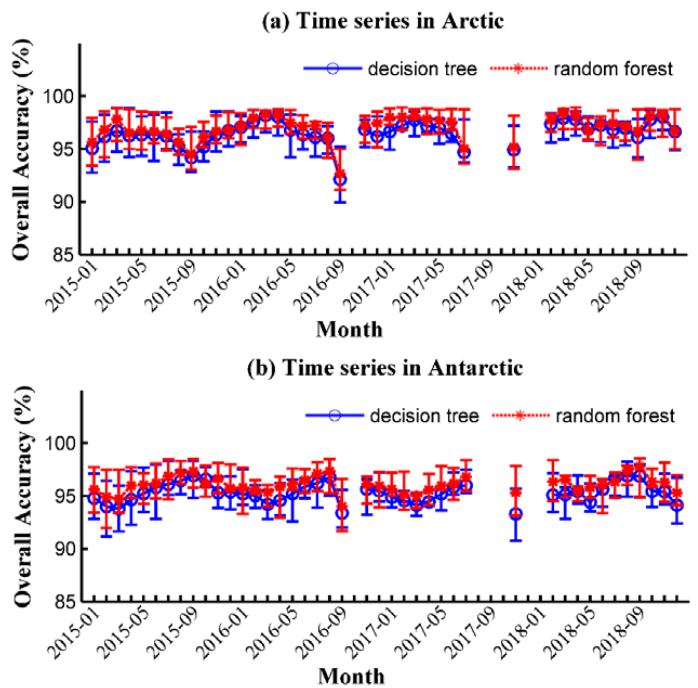
Figure 8. The time series of producer and user accuracies of sea ice monitoring results over the ( a ) Arctic and ( b ) Antarctic regions using decision tree (DT) and random forest (RF) algorithms.